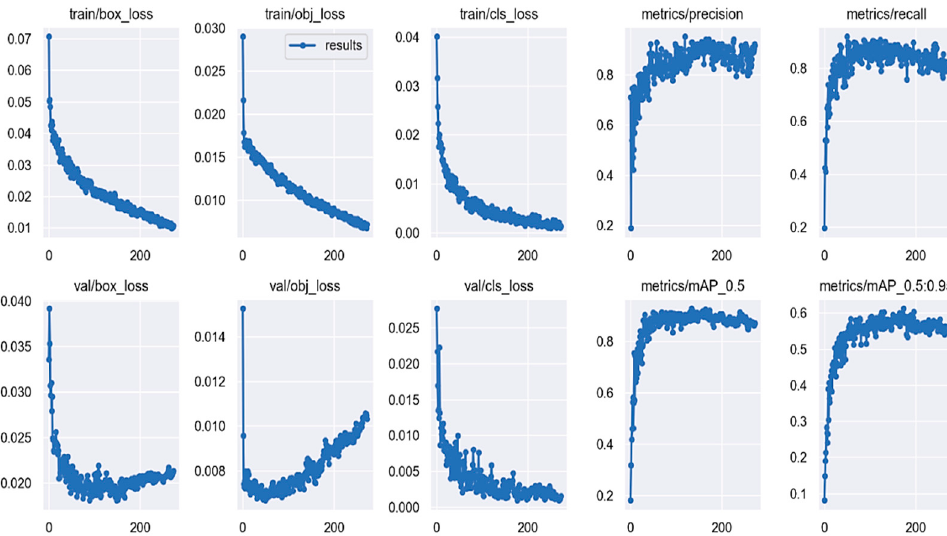
Figure 6. Illustrates the model effectiveness using different evaluation metrics, the X-axis represents the number of epochs and Y-axis are the corresponding score of each evaluation matrix.